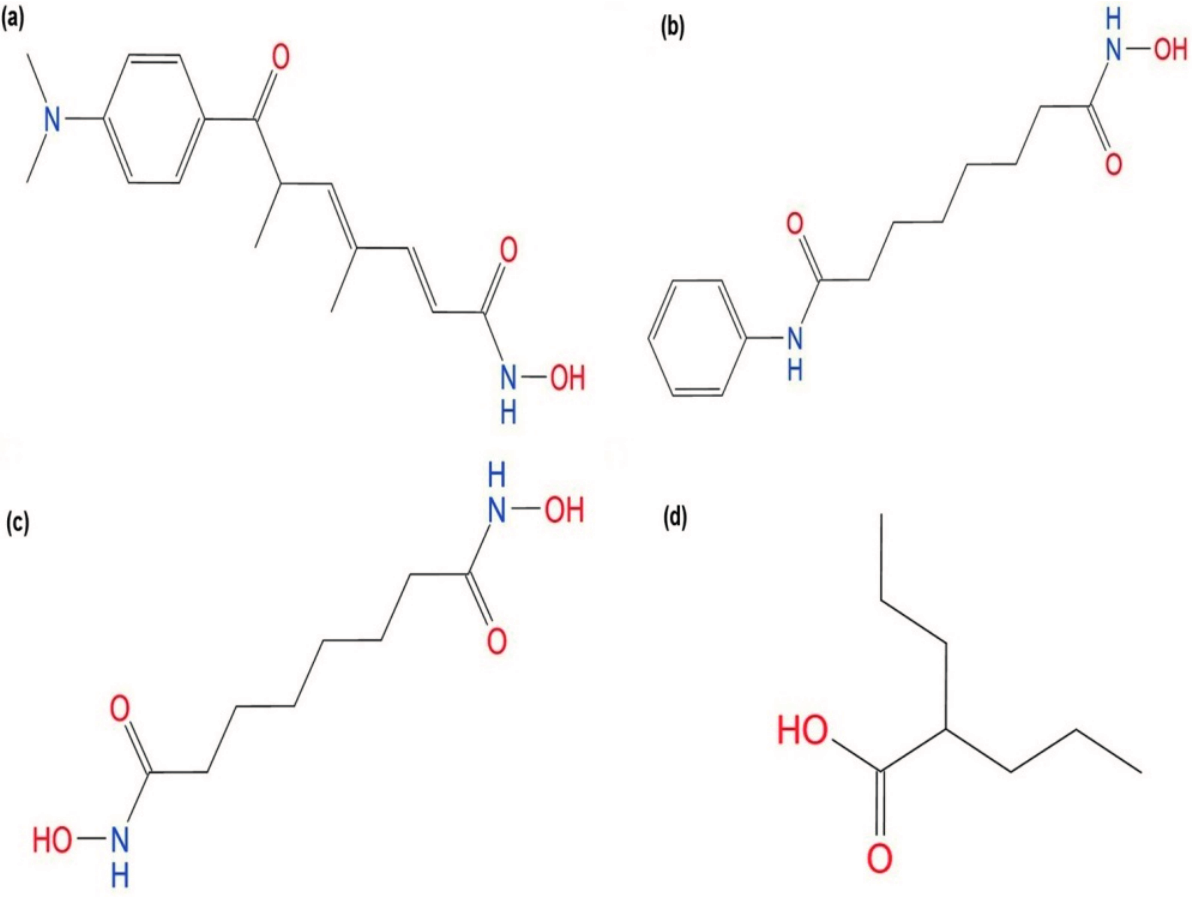
Figure 1. Two-dimensional structures of the ligands used in docking work. ( a ) Trichostatin A (TSA); ( b ) suberoylanilide hydroxamic acid (SAHA); ( c ) suberoyl bis-hydroxamic acid (SBHA); and ( d ) valproic